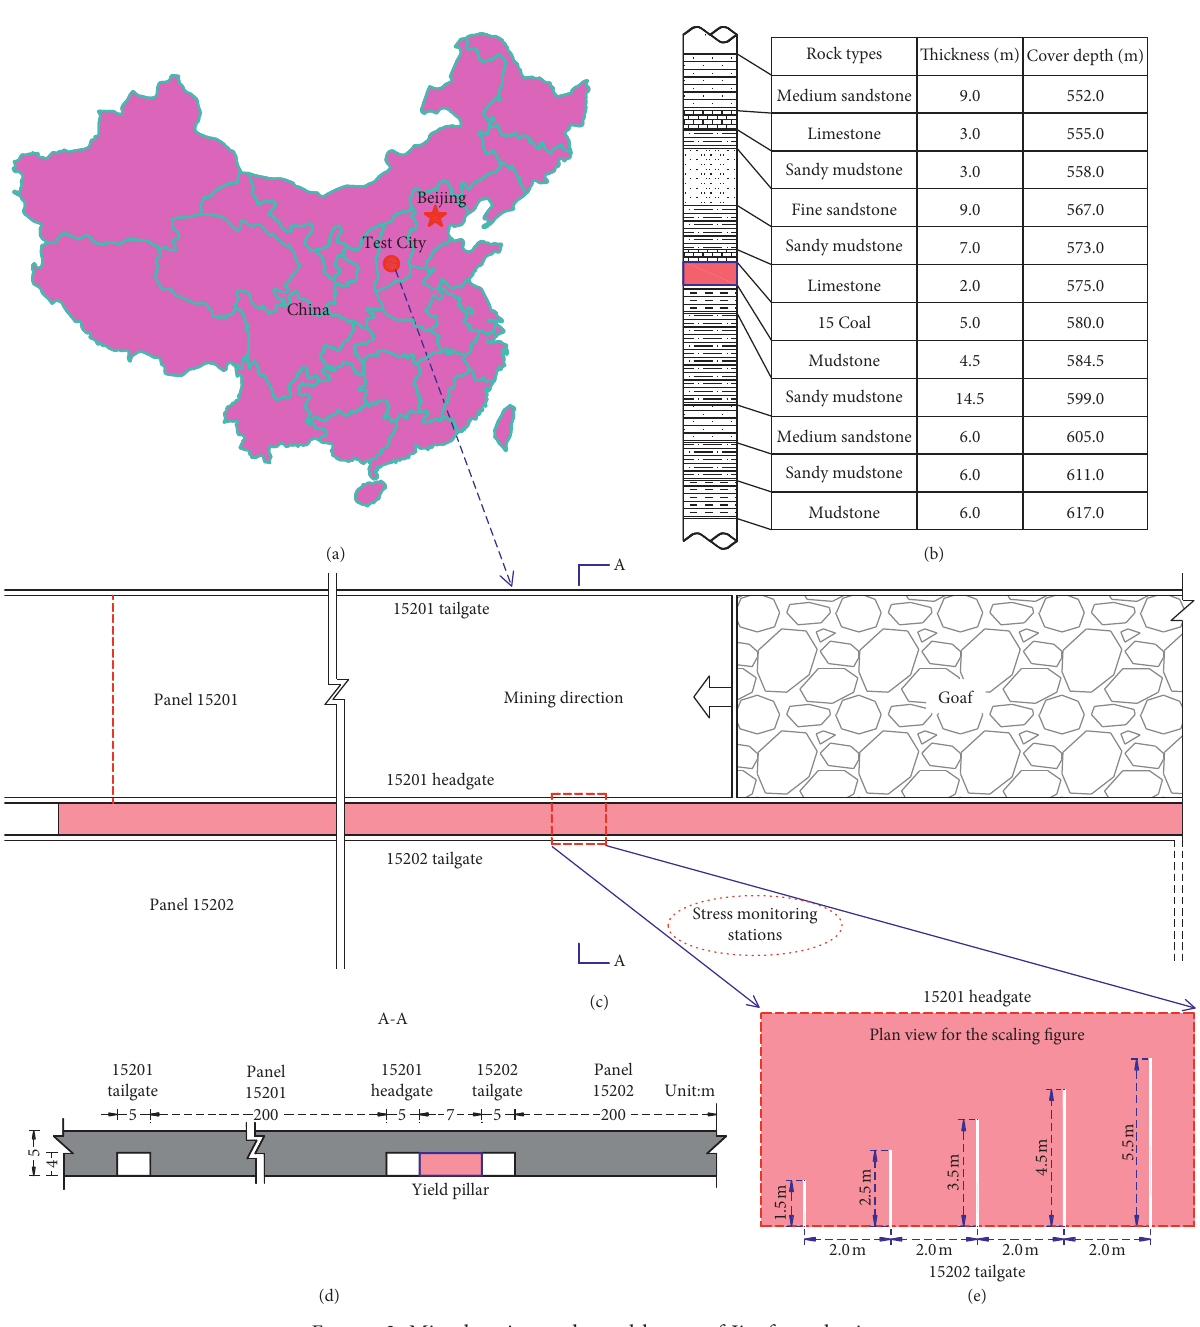
Figure 2: Mine location and panel layout of Jingfu coal